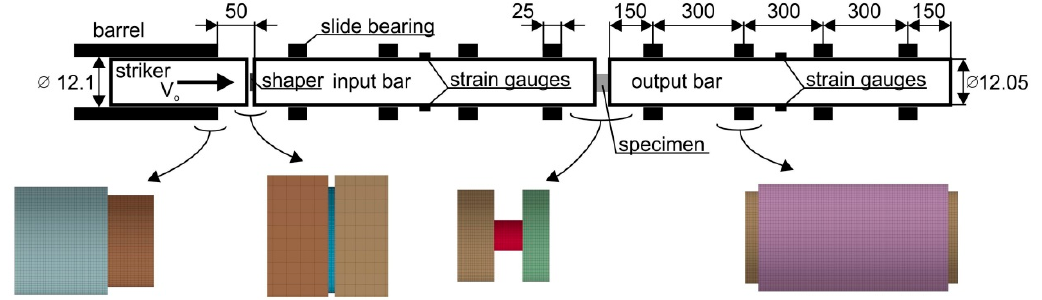
Figure 4. A schematic diagram of the SHPB set-up used in the numerical analysis.